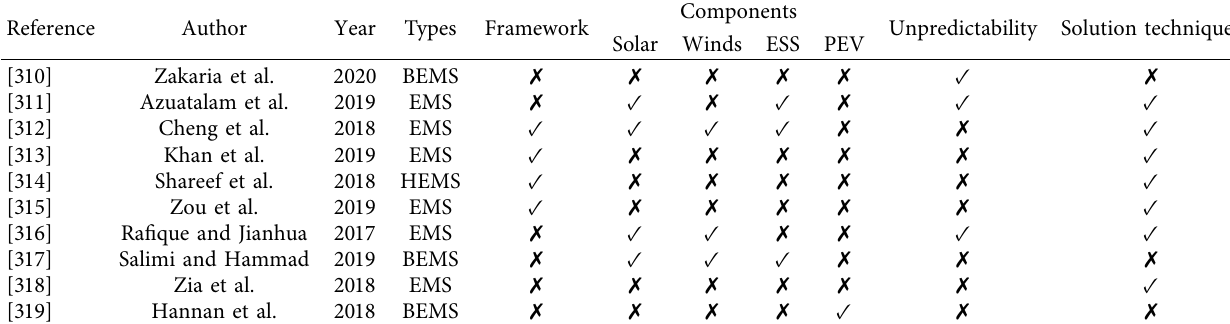
Table 11: Contributions of energy management system in smart